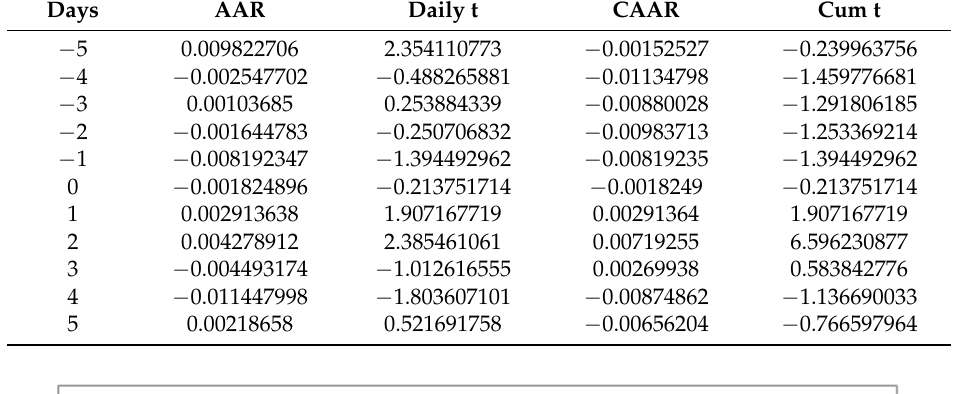
Table 2. Event study results of banks for the first event. Source: Authors’ work.